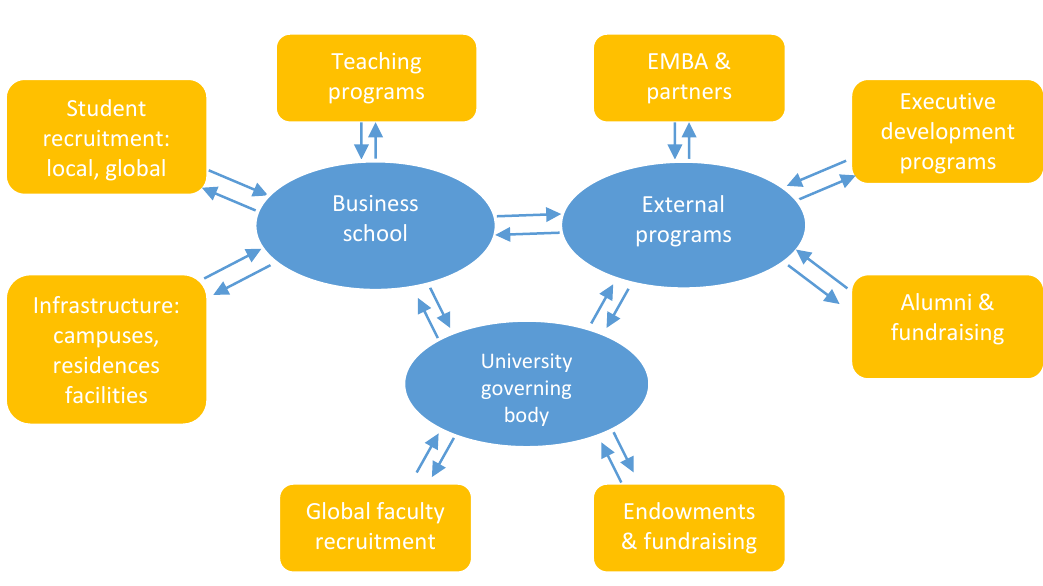
Figure 2. Business School